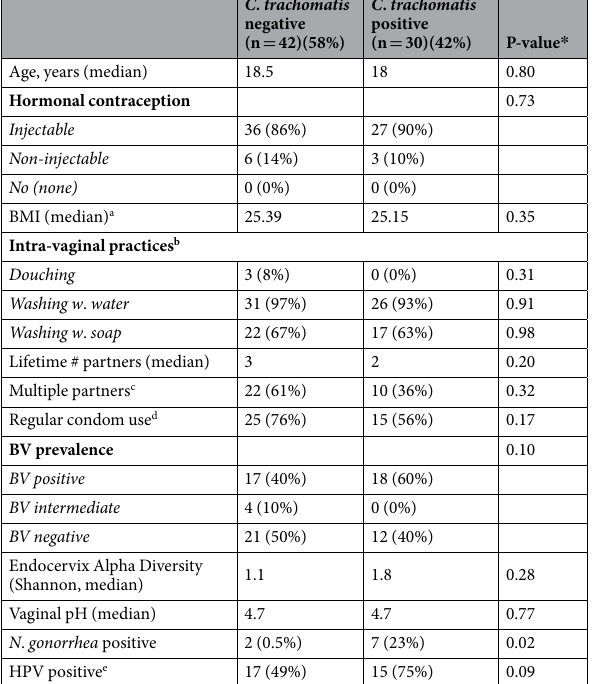
faecium , M . aerolatum , Peptoniphilus harei_asaccharolyticus_grossensis and Megasphaera which were more prom- inent in endocervical samples, and Anaerococcus , F . magna , Dialister and Corynebacterium ssp., which were more common in lateral wall samples (Fig. 2d, AUC = 0.98, PPV = 0.96, NPV = 0.90 for the test set and a validation predicted error rate of 6.25%).